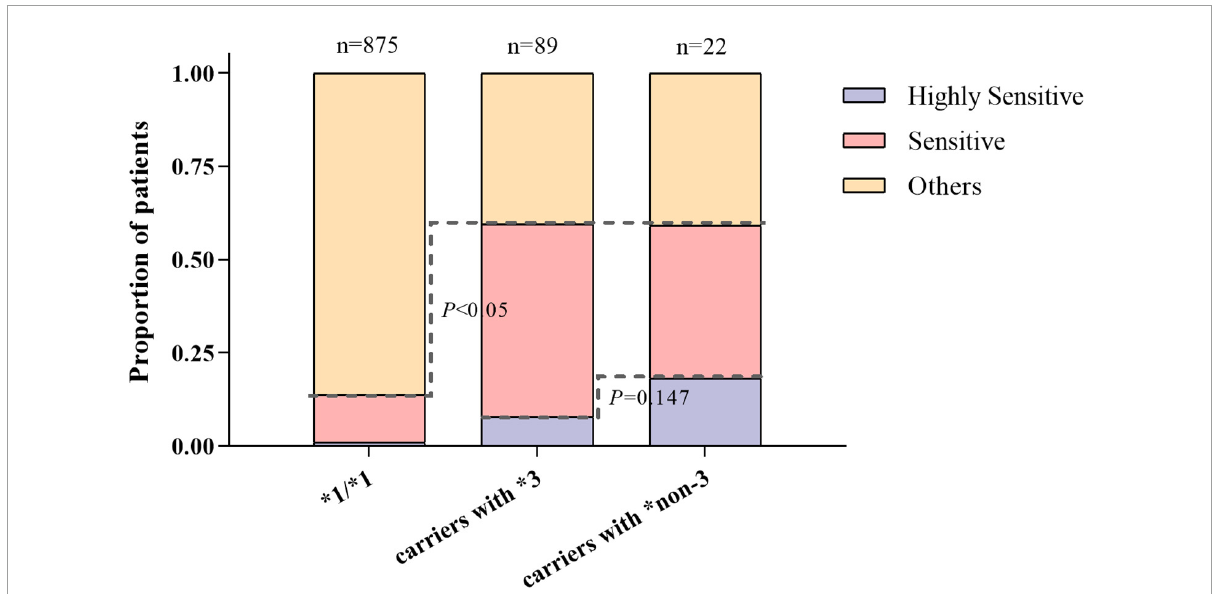
FIGURE3 The distribution of warfarin sensitive and highly sensitive responders with different CYP2C9